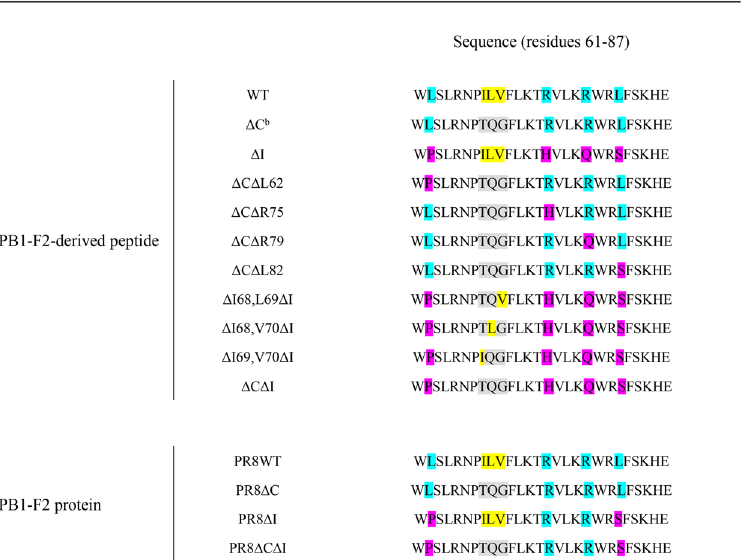
Figure 2. Sequences of H1N1 PB1-F2-derived peptides and corresponding proteins in reverse-genetics viruses used in these studies. Sequences are shown for 27mer C-terminal region of PB1-F2s. Yellow shading highlights the residues shown to enhance cytotoxicity in case of A/Puerto Rico/8/1934(H1N1) (PR8) 31 , and light gray shading indicates the changes to these residues. Turquoise shading indicates residues shown to enhance PB1- F2-related inflammation in the case of pandemic A/Hong Kong/1/1968(H3N2) 16 , and pink shading indicates the changes to these residues on the PR8